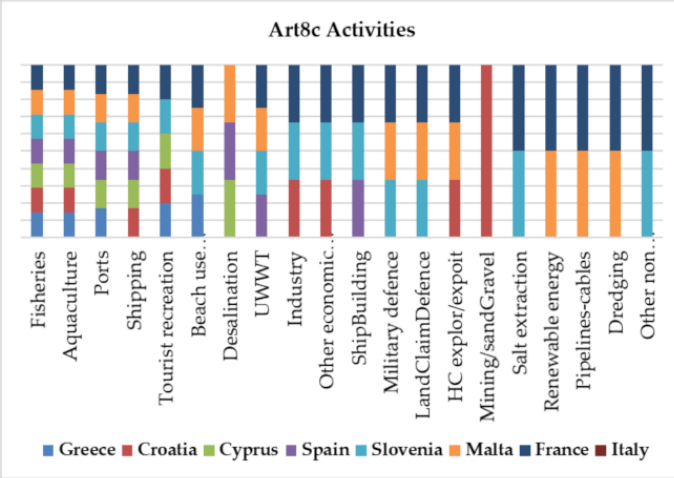
Figure 4. Marine economic activities reported by Mediterranean MSs under Art 8c in